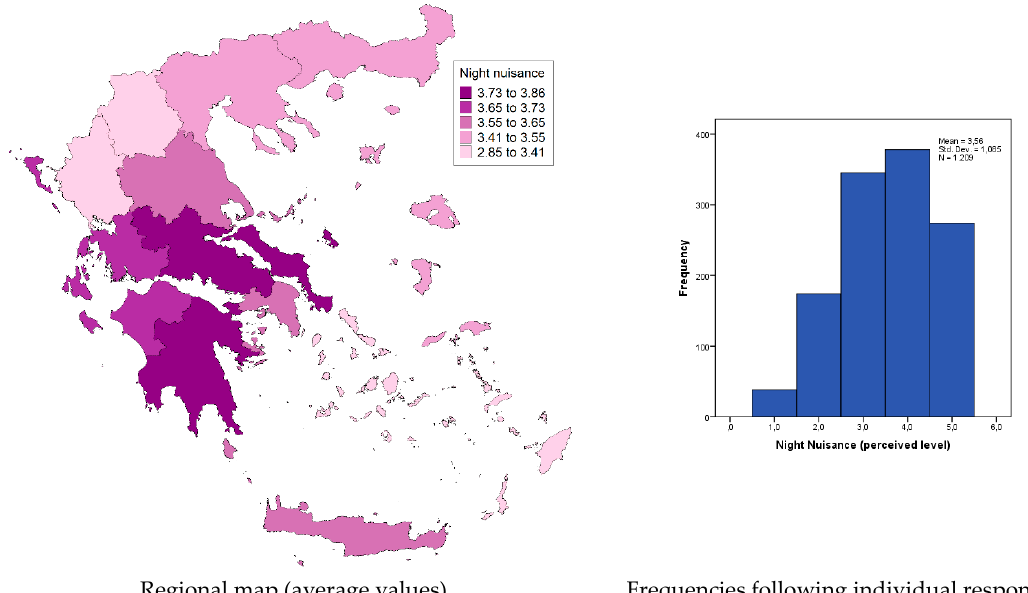
Figure 2. Night nuisance (Likert scale 1–5: 1, no nuisance; 5, intolerable